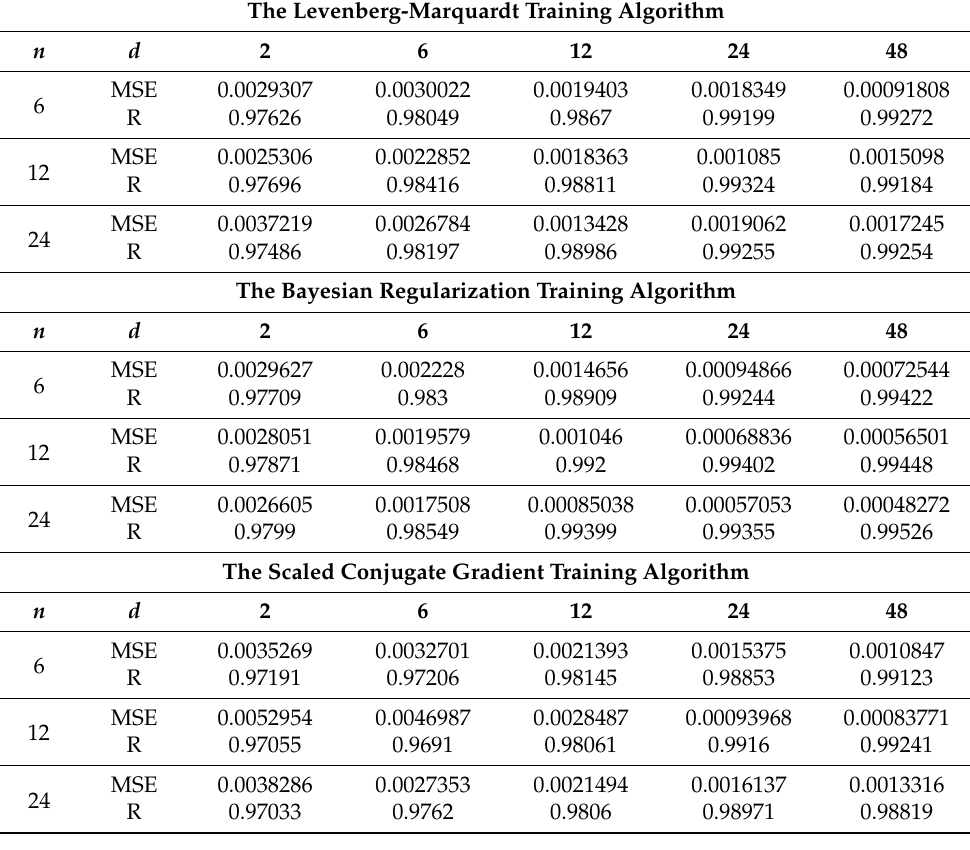
Table 2. The synthesis of the experimental results when developing the artificial neural networks forecasting solution based on the NAR